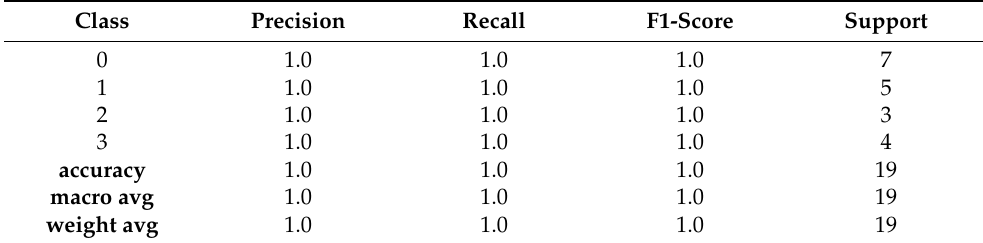
Table 2. Ensemble model metrics for sorting tuna samples.